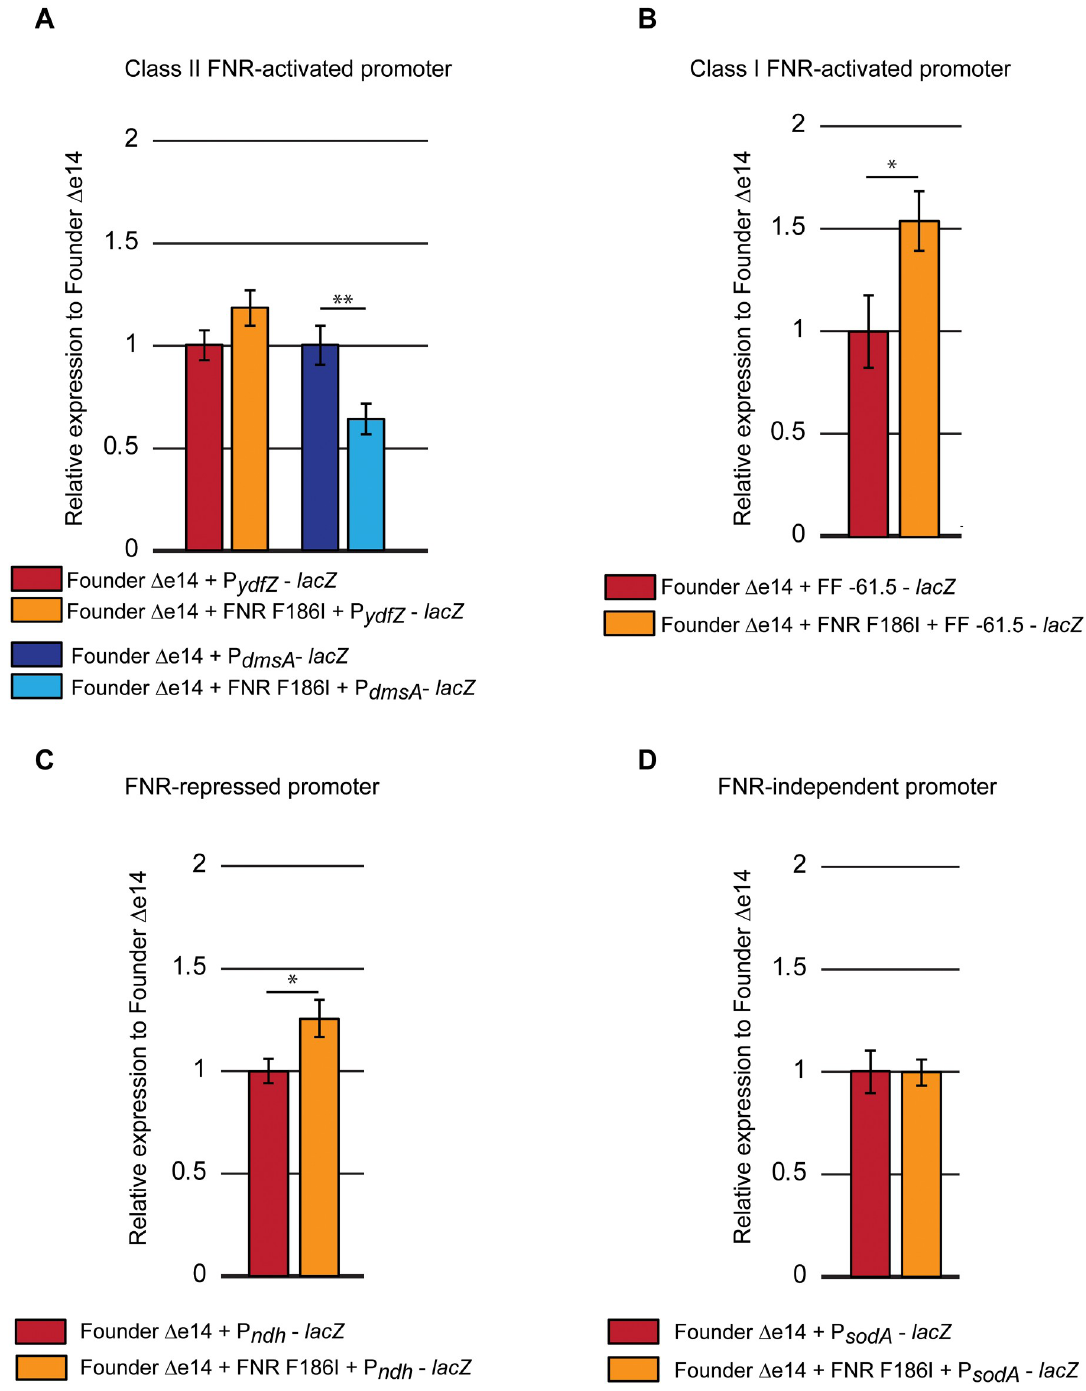
Fig 2. β -galactosidase activity of promoter- lacZ fusions in Founder Δ e14 + FNR F186I at exponential phase growth. β -galactosidase activity was assayed at exponential phase (OD 600 = 0.2) β -gal activity was normalized to the average β -gal activity of Founder Δ e14 with the appropriate lacZ fusion (containing the wild-type FNR F186 allele). These fusions have been previously described [16, 18–20]. The β -galactosidase assay was carried out as described in the Materials in Methods section. These data represent the results of two independent experiments carried out in biological triplicate or duplicate for the repeat experiment. Statistical significance was determined using a two-tailed Student’s t-tests. P-values are indicated using the ‘ � ’ (p < 0.05), ‘ �� ’ (p < 0.01), and ‘ ��� ’ (p < 0.001) symbols. Data for these experiments are contained in the Supporting Information (S3 File. Beta-galactosidase raw data).